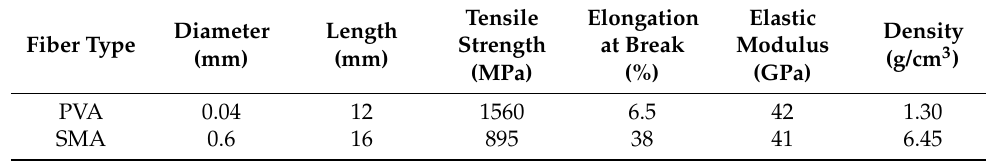
Table 4. Mechanical properties of PVA and SMA fiber.